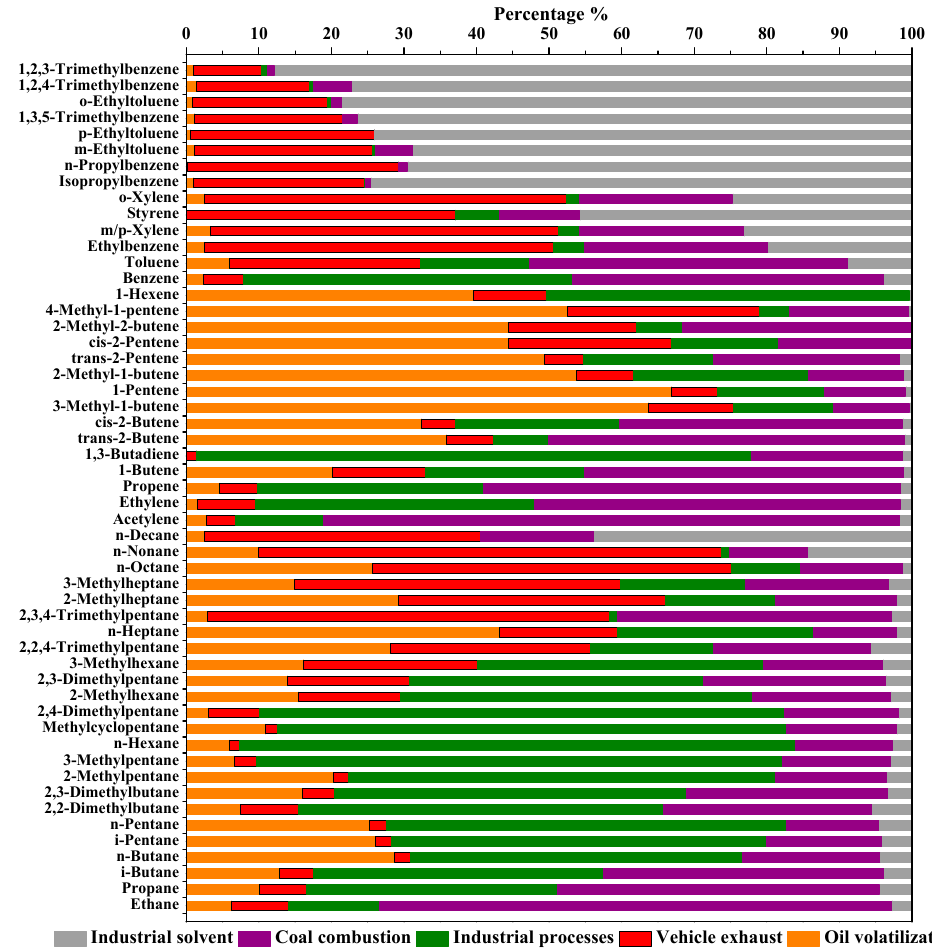
Figure 5. Source profiles resolved from Positive Matrix Factorization (PMF) during sampling periods in Dushanzi.